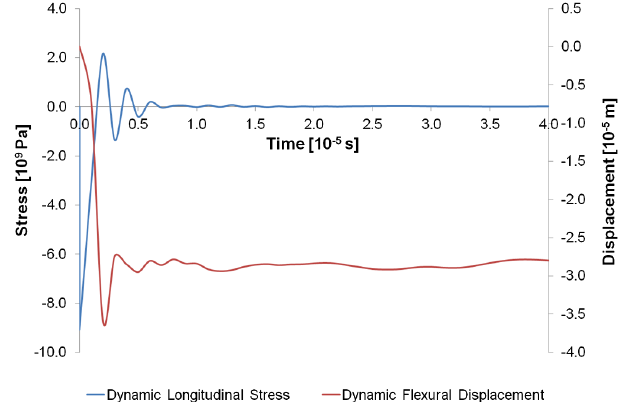
FIG. 20. Longitudinal stresses ( z -direction) on the collimator jaw assembly due to the particle beam impact. High compressive stresses dominate the region of the maximum energy deposition. A detailed view is shown in the inset.